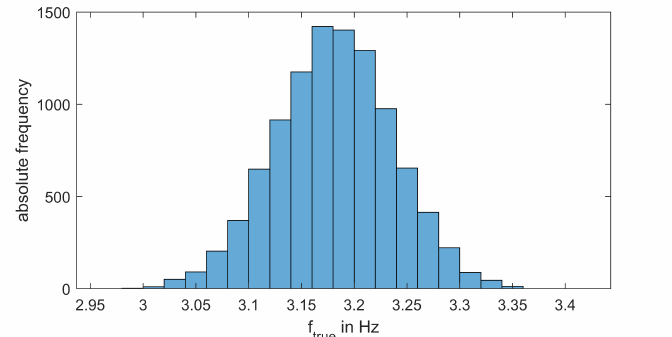
Figure 7. Distribution of the natural frequency from training data